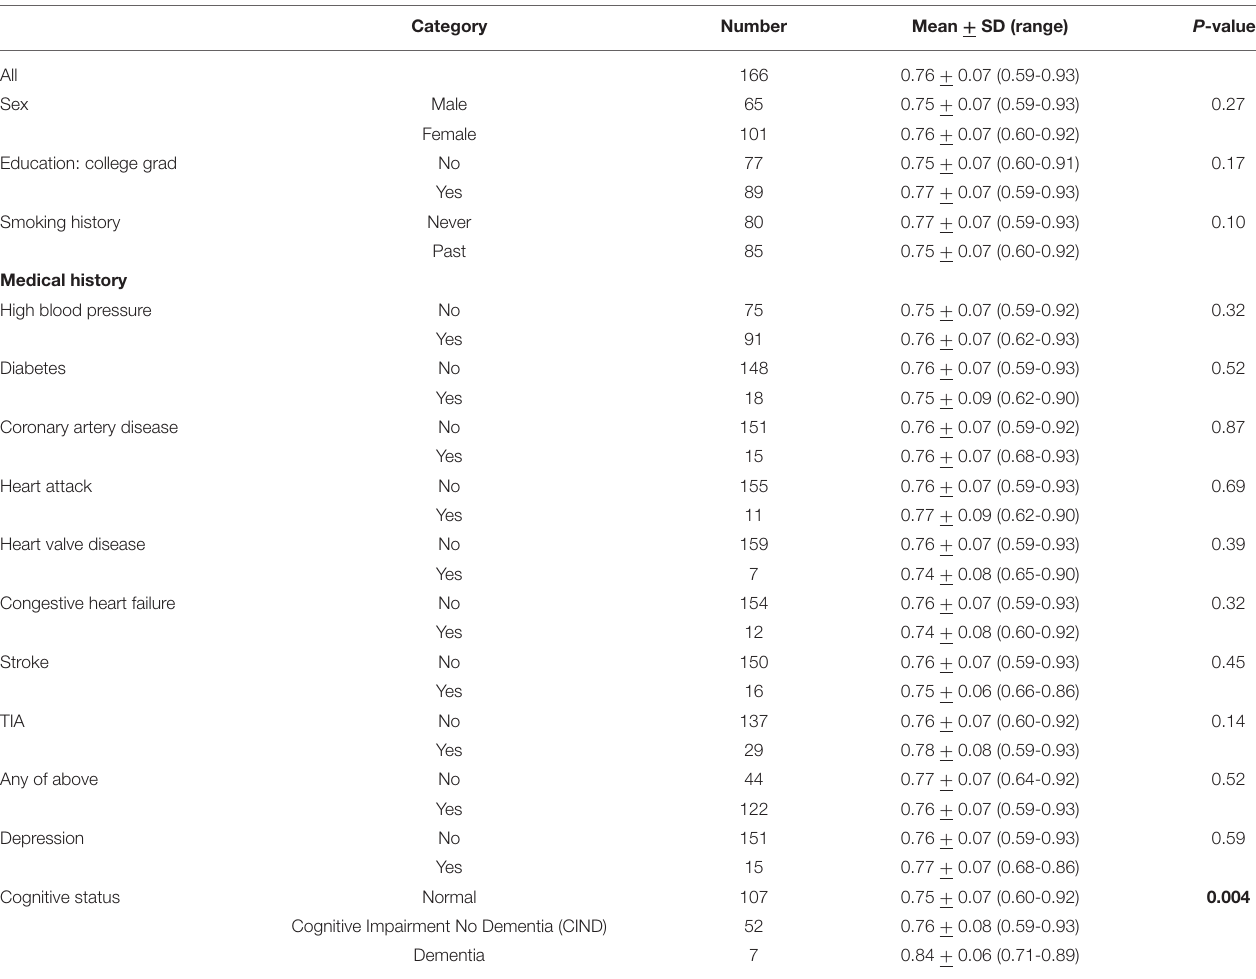
TABLE 1 | Mean + standard deviation (SD) of brain amyloid- β burden measured via positron emission tomography statistically defined region of interest scores (PET statROI) by participants’ characteristics, The 90 +